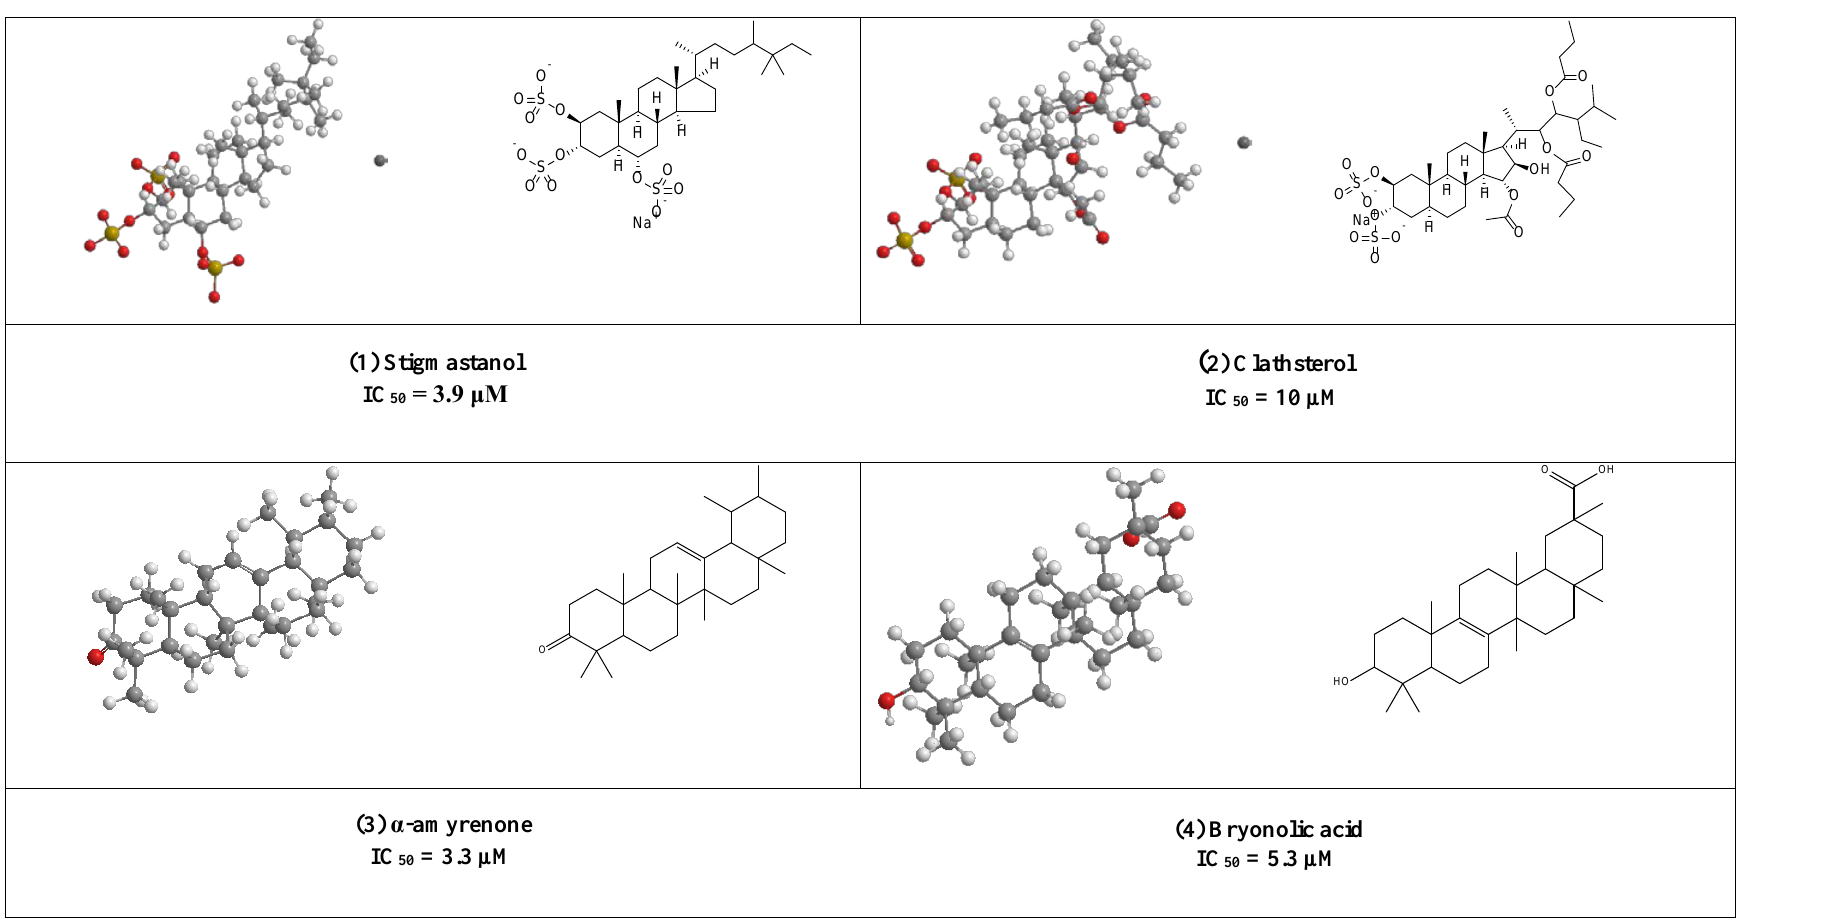
Figure 3. The 2D and 3D chemical structures of virus reverse transcriptase inhibitors. Figure 3. Cont